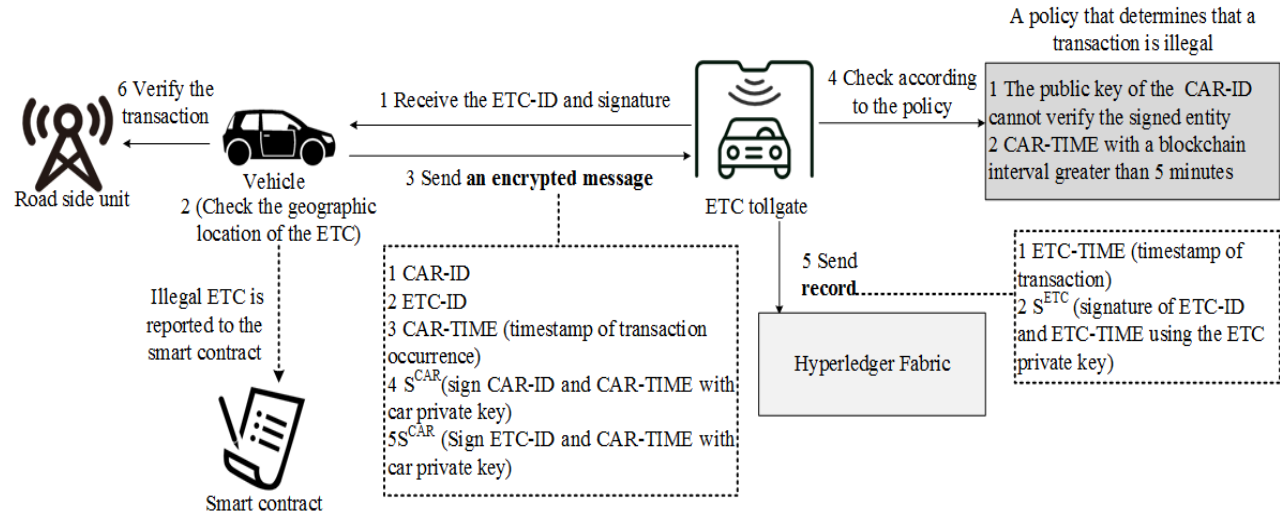
Figure 41. Reconstruction diagram of reference [73].